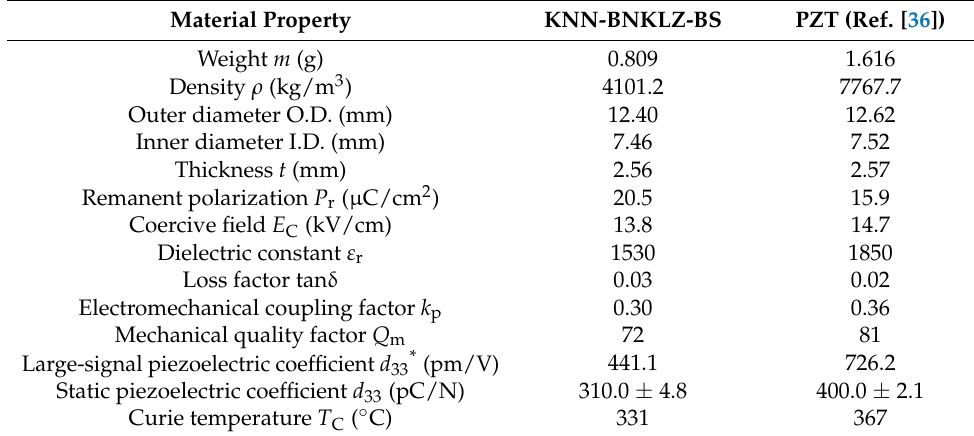
Dielectric constant ε r Loss factor tan δ Electromechanical coupling factor k p Mechanical quality factor Q m Large-signal piezoelectric coefficient d 33* (pm/V) 441.1 Static piezoelectric coefficient d 33